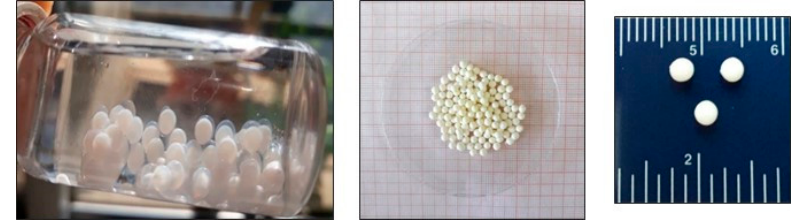
Figure 9. Photographs of PUA aerogel beads (wet-gels and aerogels) [94].